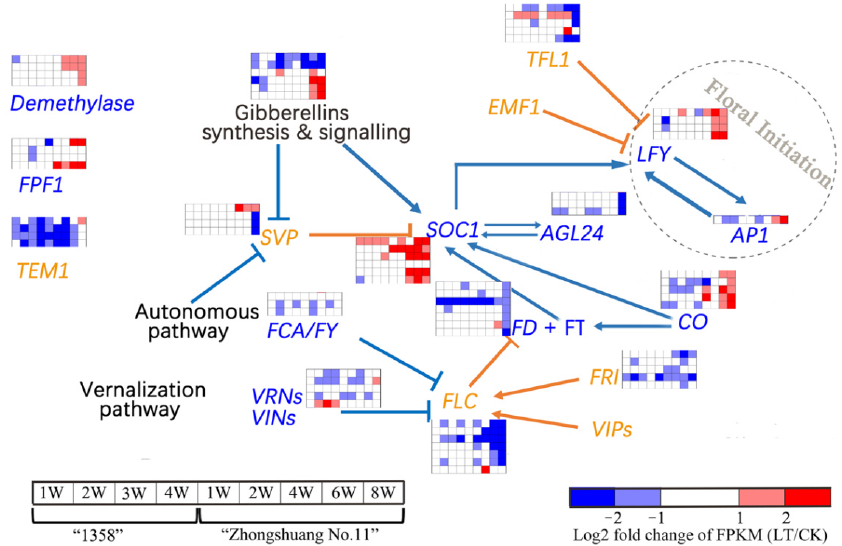
Figure 8. The gene expression difference is related to the network of floral initiation in early and late maturing varieties at different sampling times under normal and low-temperature conditions. The flow chart of floral initiation in Arabidopsis is abstracted from a previous review by Putterill et al. and Wellmer et al. [32,33]. The main ways to induce floral initiation are gibberellin synthesis and signaling, vernalization, and autonomous pathways. Arrow and binding lines indicate the expression of promoting and inhibiting genes, respectively. Blue and yellow genes correspond to promoting and inhibiting floral initiation, respectively. The floral initiation promote genes include Agamous-like 24 ( AGL24 ), Apetala1 ( AP1 ), Constans ( CO ), Flowering time control protein FCA/FY ( FCA/FY , Flowering locus T ( FT ), Flowering-promoting factor 1 ( FPF1 ), Leafy ( LF ), Vernalization genes ( VRNs ), Vernalization insensitive genes ( VINs ), Suppressor of Overexpression of Constans ( SOC1 ) and so on; the floral initiation inhibited genes included Embryonic flower 1 ( EMF1 ), Flowering locus C ( FLC ), Frigida ( FRI ), MADS-box gene short vegetative phase ( SVP ), Tempranillo1 ( TEM1 ), Terminal flower 1 ( TFL1 ), Vernalization independence genes ( VIPs ) and so